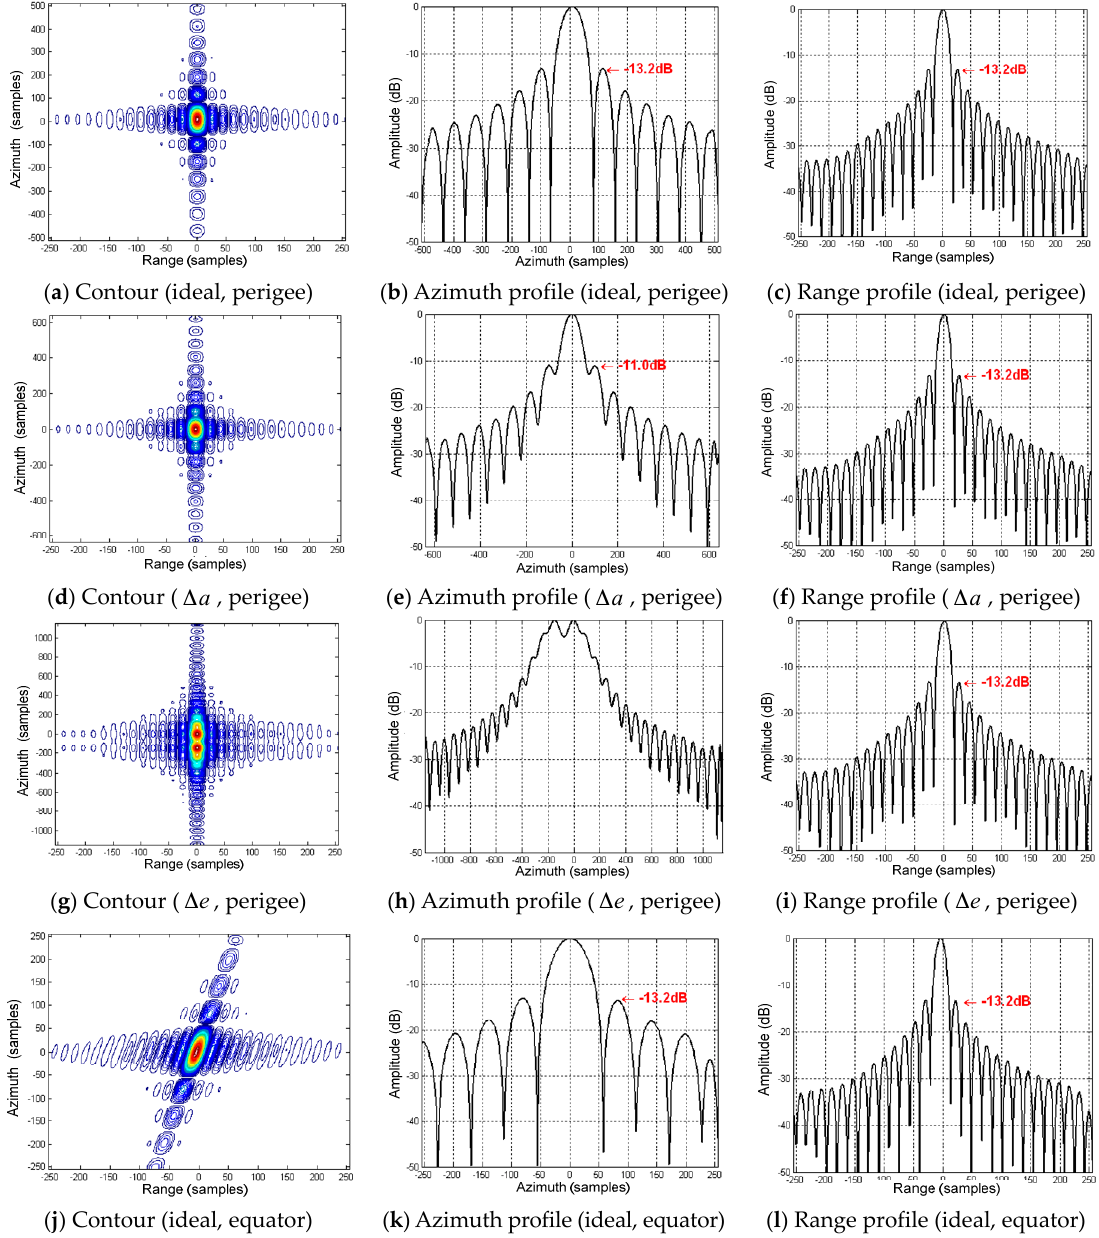
Figure 7. Perturbed imaging results of the simulated point targets in GEO SAR when considering the variations of the semi-major axis and eccentricity.